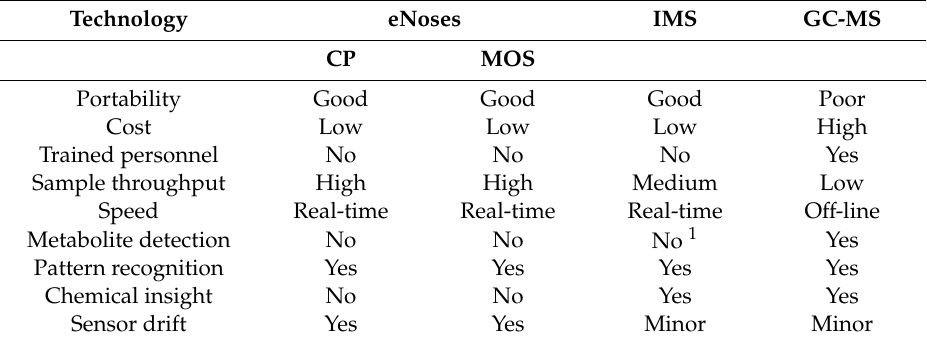
Table 1. Characteristics of Volatile Organic Compound Detection